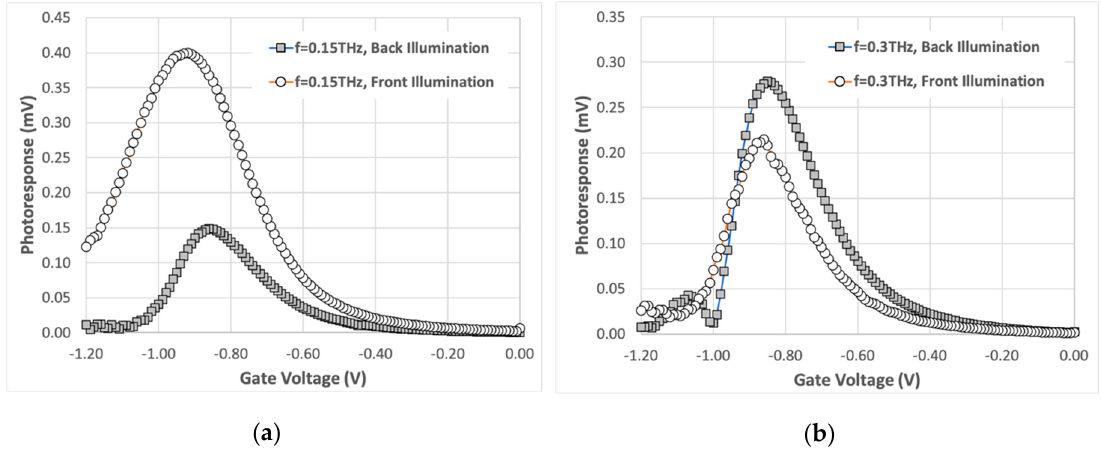
Figure 5. Photoresponse signal vs. gate voltage under excitation of ( a ) 0.15 THz and ( b ) 0.3THz and for both front and back illumination configurations.